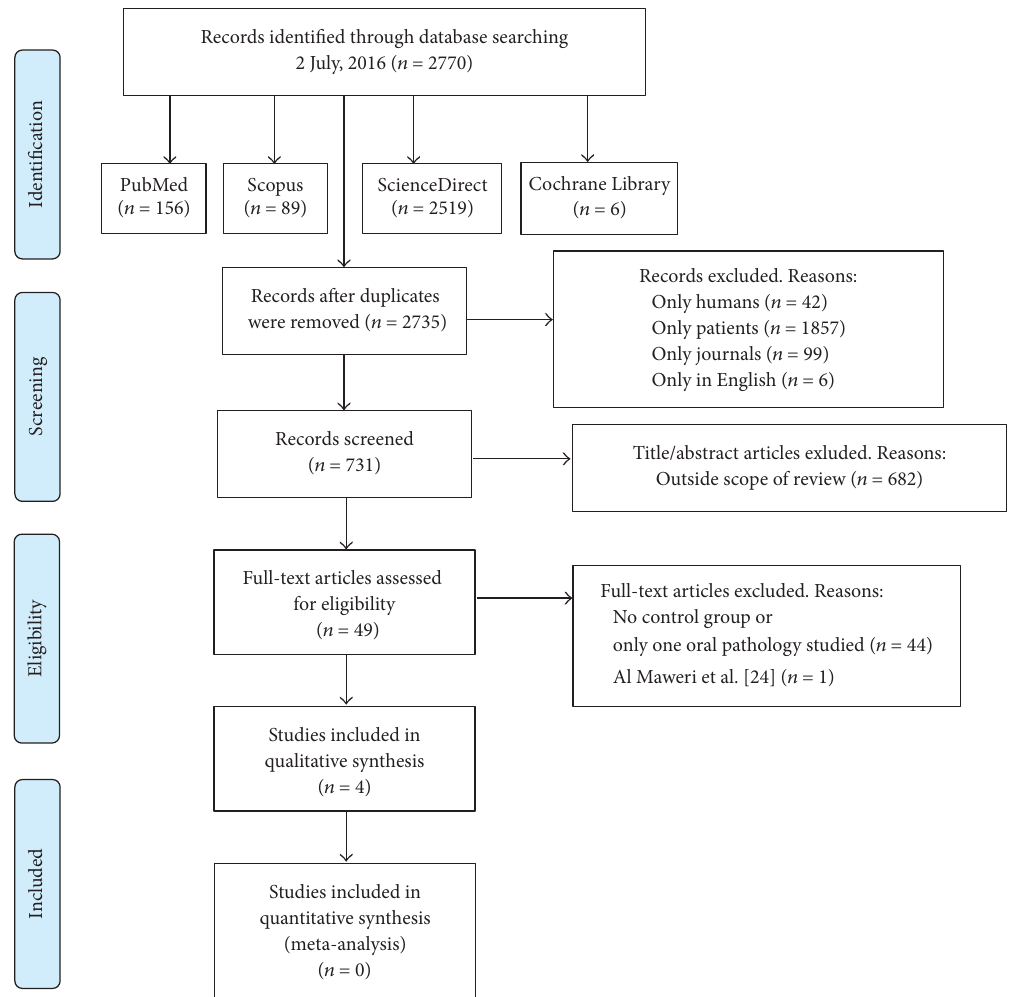
Figure 1: Flow diagram of the literature search, according to the Preferred Reporting Items for Systematic Reviews and Meta-Analyses (PRISMA). PubMed/MEDLINE, Scopus, and ScienceDirect: (diabetes OR “diabetes mellitus”) AND (“oral mucosal lesions” OR “oral diseases” OR “oral pathology”) AND (prevalence OR diagnosis); Cochrane Library: (diabetes OR (diabetes mellitus)) AND ((oral mucosal lesions) OR (oral diseases) OR (oral pathology)) AND (prevalence OR